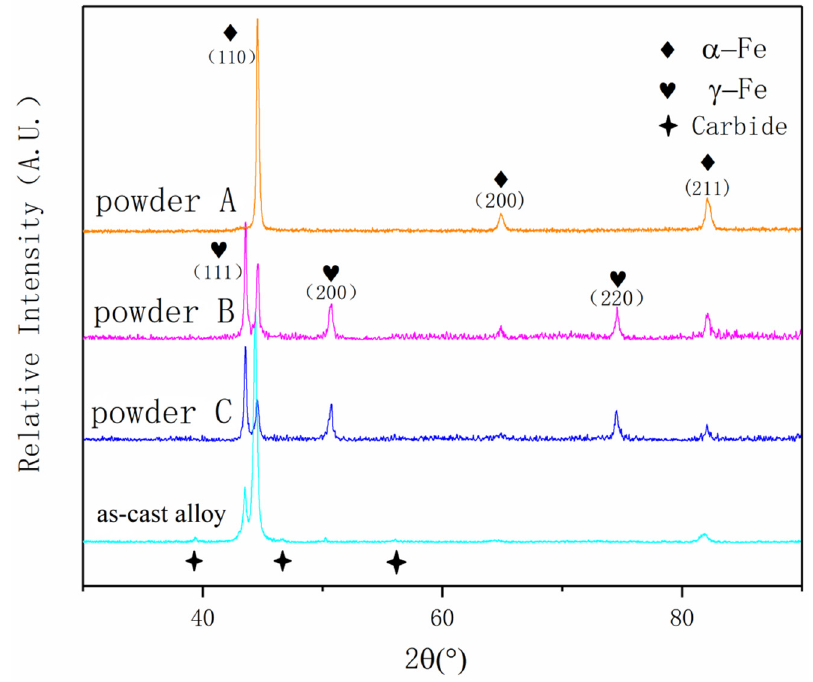
Figure 5. X-ray diffraction results of powders and as-cast alloy.